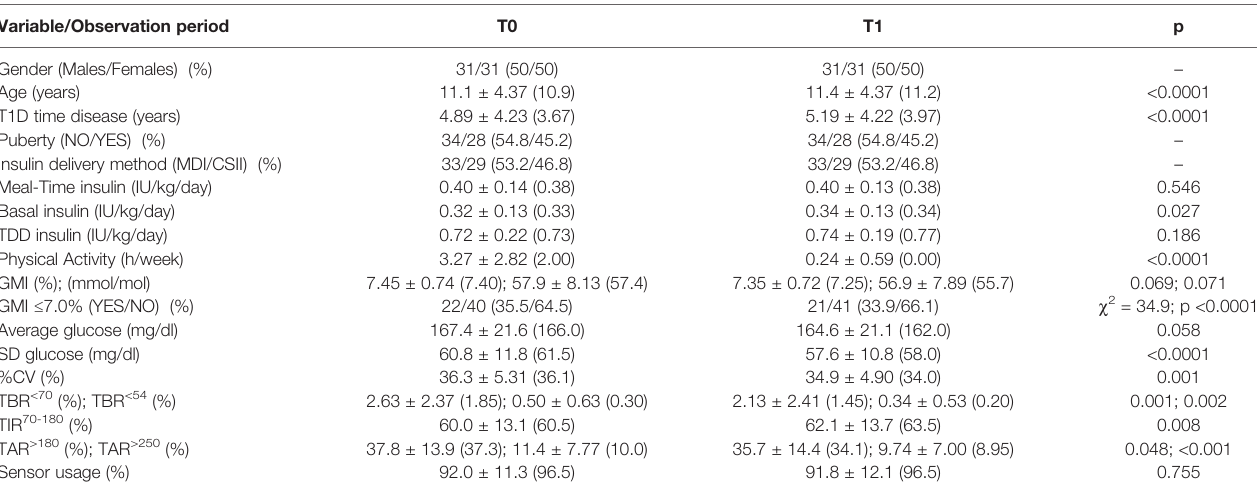
TABLE 1 | Clinic, therapy, and glycemic control parameters in children and adolescents with T1D. Variable/Observation period T0 Gender (Males/Females)